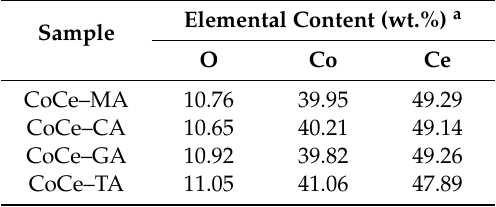
Table 3. Elemental content of the CoCe–X catalysts.